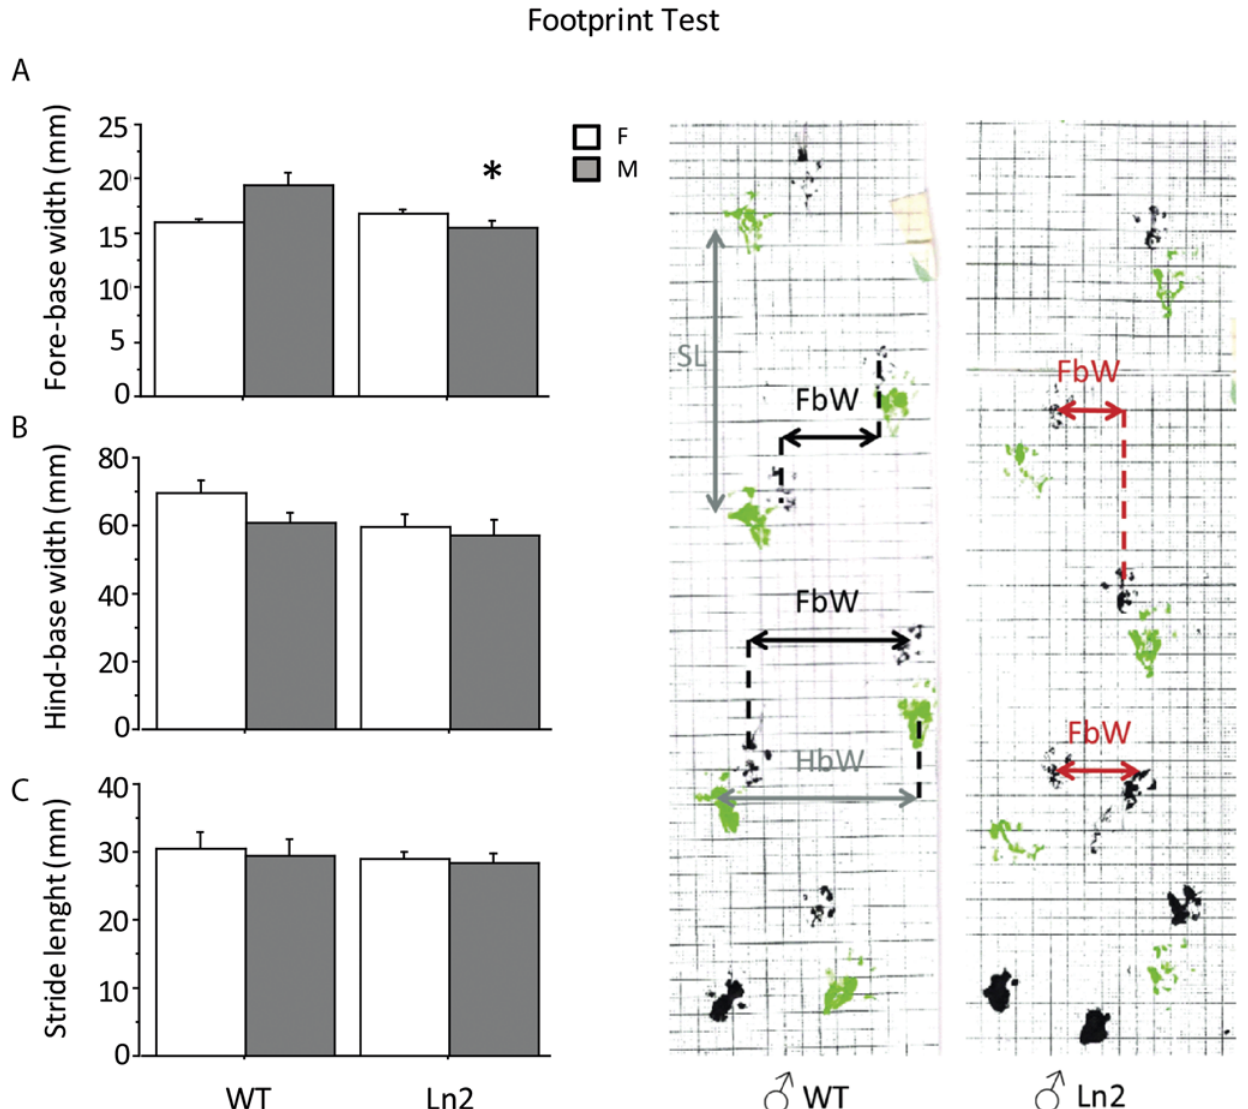
Fig 5. Assessment of gait using Footprint test. Tg old male mice (18 month-old) showed a significantly reduced fore-base width compared to controls (A) . Results are presented as mean + S.E.M. * P <